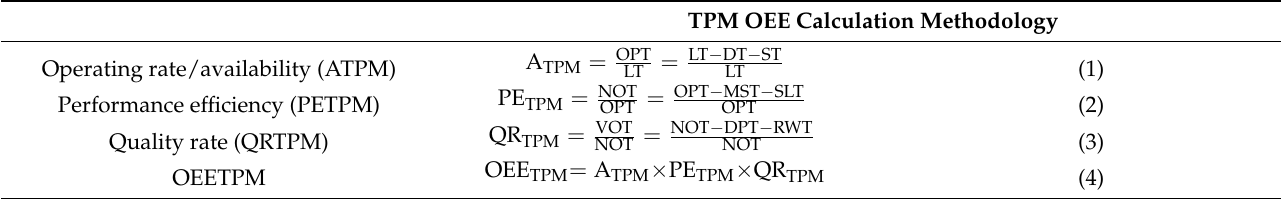
Table 2. Calculation of the TPM